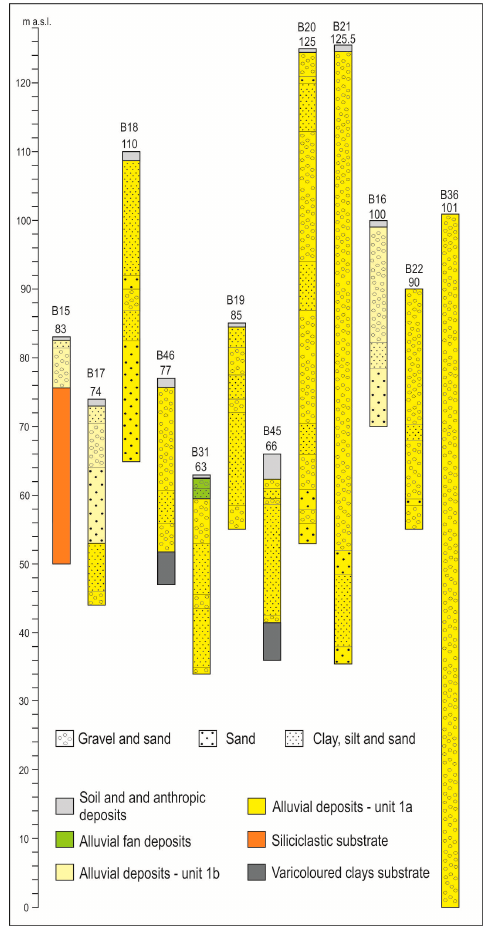
Figure 3. Stratigraphical logs of boreholes drilled through the AL deposits. For location, see Figure 2.